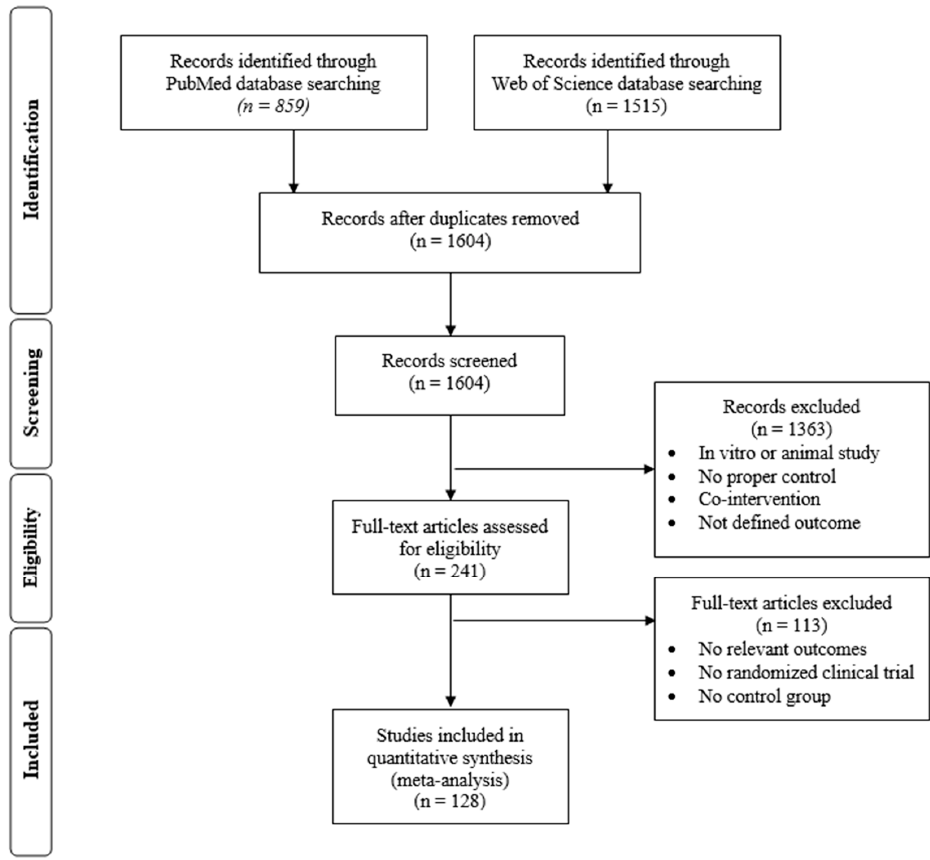
Figure 1. Flow diagram showing the study selection process.